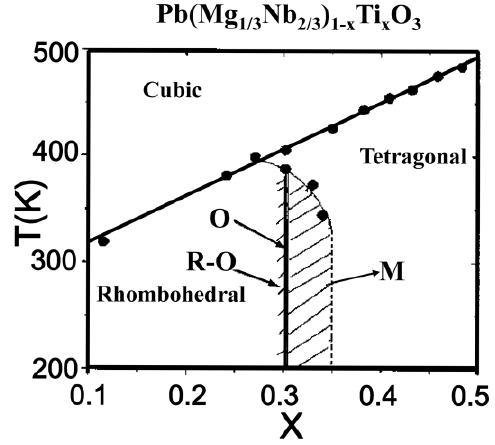
Figure 2. Phase diagram of the PMN-xPT binary system (with permission from